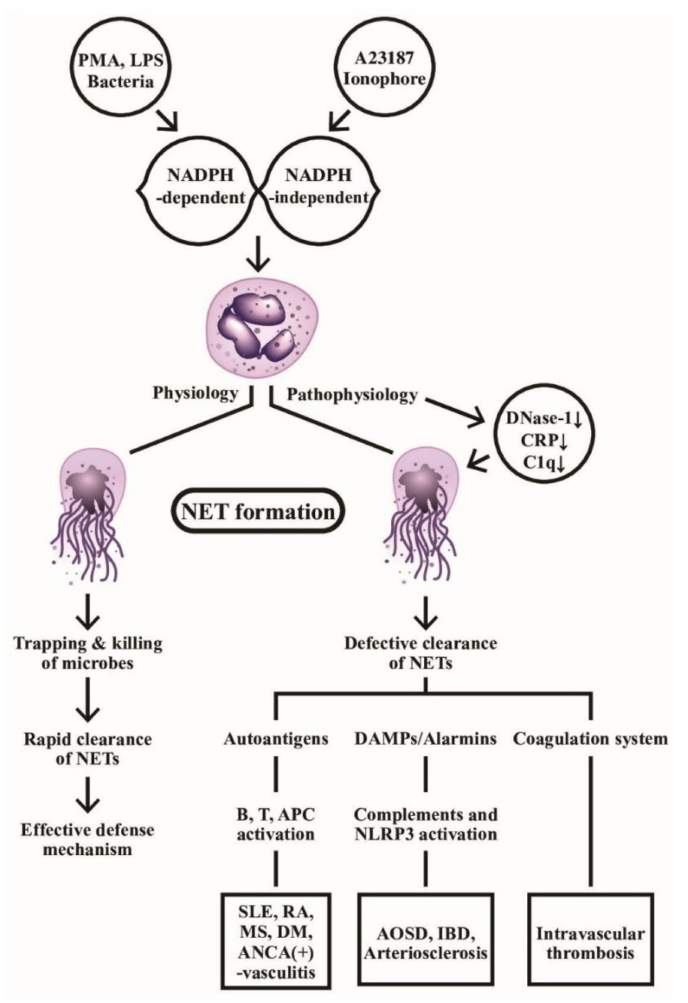
Figure 2. The physiological and pathophysiological roles of NADPH-dependent and NADPH- independent neutrophil extracellular traps (NETs) formation are demonstrated. Left: the web- like NETs with attached granule enzymes not only effectively trap but kill the invasive microbial pathogens as an important defense mechanism in normal physiological condition. Right: Defective NET clearance due to defective DNase-1, CRP, and C1q functions may lead to longstanding presence of the NET in the blood and tissues. These molecules may become autoantigens, damage-associated molecular patterns (DAMP)/alarmins stimulants, or coagulation system activator to induce autoim- munity, inflammatory reaction, and intravascular thrombosis. PMA: phorbol myristate acetate; LPS: lipopolysaccharide; AOSD: Adult onset Still’s disease; MS: multiple sclerosis; IBD: inflammatory bowel disease; DM: diabetes mellius; NLRP: Nucleotide-binding oligomerization domain, Leucine rich Repeat and Pyrin domain containing; APC: antigen presenting cell; ANCA: anti-neutrophil cytoplasmic antibody; SLE: systemic lupus erythematosus; RA: rheumatoid arthritis; CRP: C-reactive protein; NADPH: nicotinamide adenine dinucleotide phosphate-hydrogen